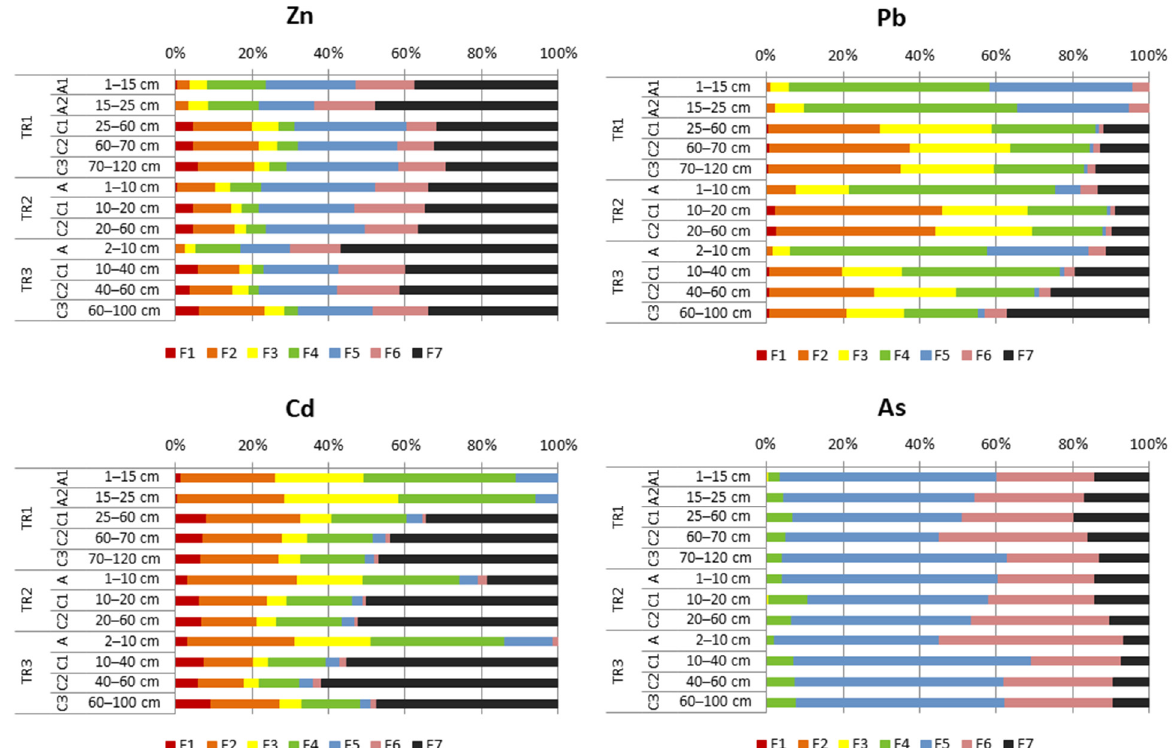
Figure 3. Chemical forms of Zn, Pb, Cd and As in the studied soils. Explanation of chemical forms of elements: F1—exchangeable (i.e., unspecifically adsorbed) elements, as well as easily soluble elements in organometallic com- plexes; F2—specifically adsorbed and near-surface occluded elements, elements bound to CaCO 3 , as well as elements in organometallic complexes of low bond strength; F3—elements bound to manganese oxides; F4—elements bound to organic matter; F5—elements bound to amorphous or poorly crystalline iron oxyhydroxides; F6—elements bound to crystalline iron oxyhydroxides; F7—elements in residual fraction.